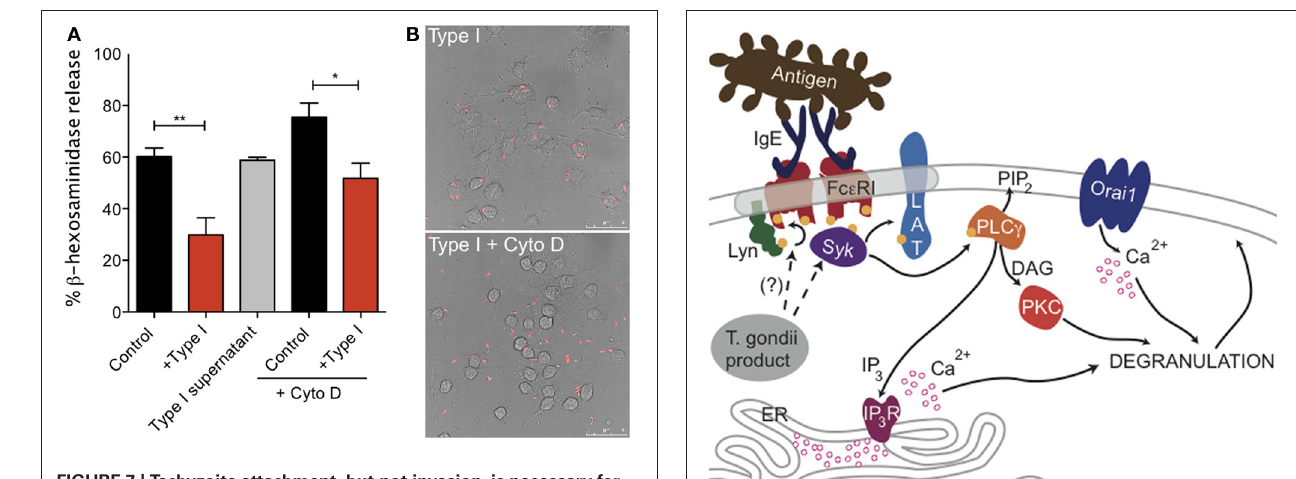
FIGURE 7 | Tachyzoite attachment, but not invasion, is necessary for inhibition of degranulation. (A) RBL-2H3 cells were incubated with parasites (Type I) in the presence or absence of cytochalasin D or with supernatants from parasites (Type I supernatant). Degranulation stimulated by multivalent antigen (10ng/ml DNP-BSA) was assessed by β -hexosaminindase release after 1h of infection as described in Materials and Methods. For Control, + Type I, Control + Cyto D and + Type I + Cyto D error bars represent SEM ( n = 4) ( ∗ P < 0 . 05 and ∗∗ P < 0 . 01 relative to control cells); for Type I supernatant, error bar represents range ( n = 2). (B) Representative confocal microscopy of RBL cells infected with RH tomato parasites in the presence (bottom panel) or absence (top panel) of cytochalasin D.